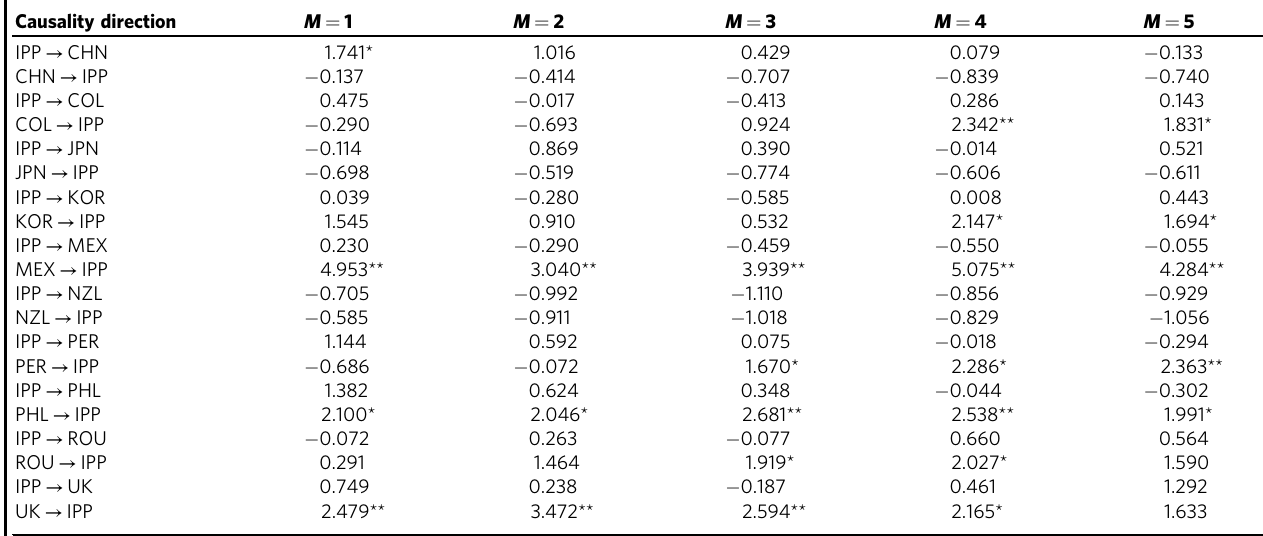
Table 6 Results for causality-in-mean